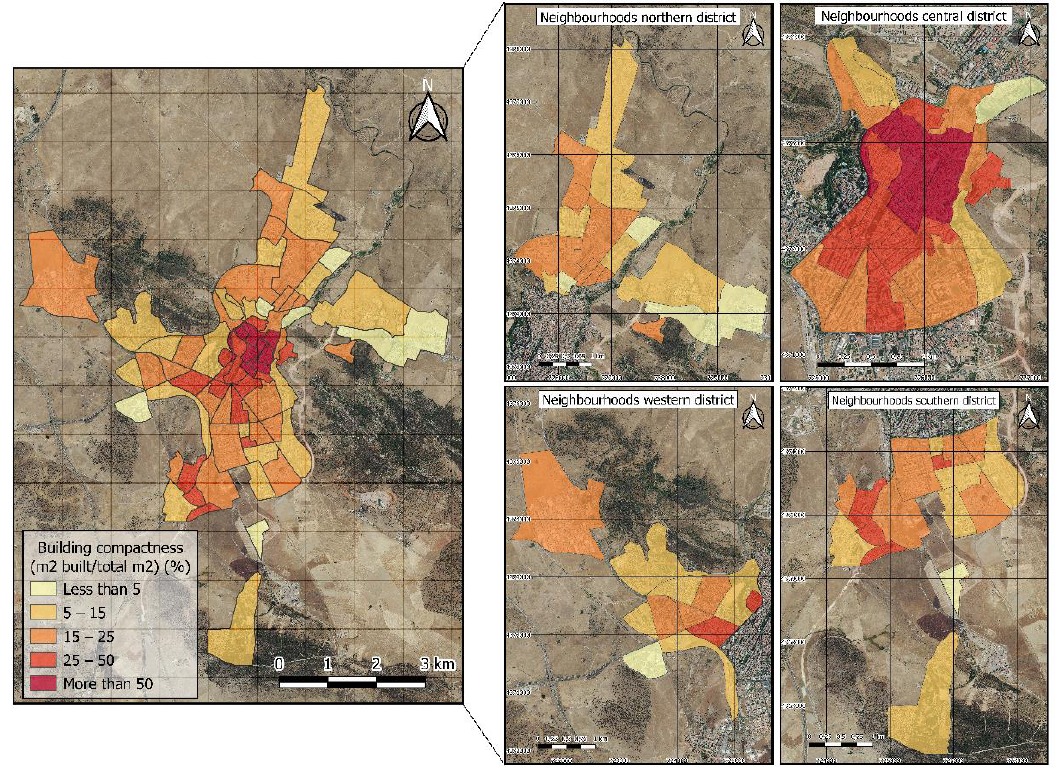
Figure 9. Building compactness at the neighborhood level.